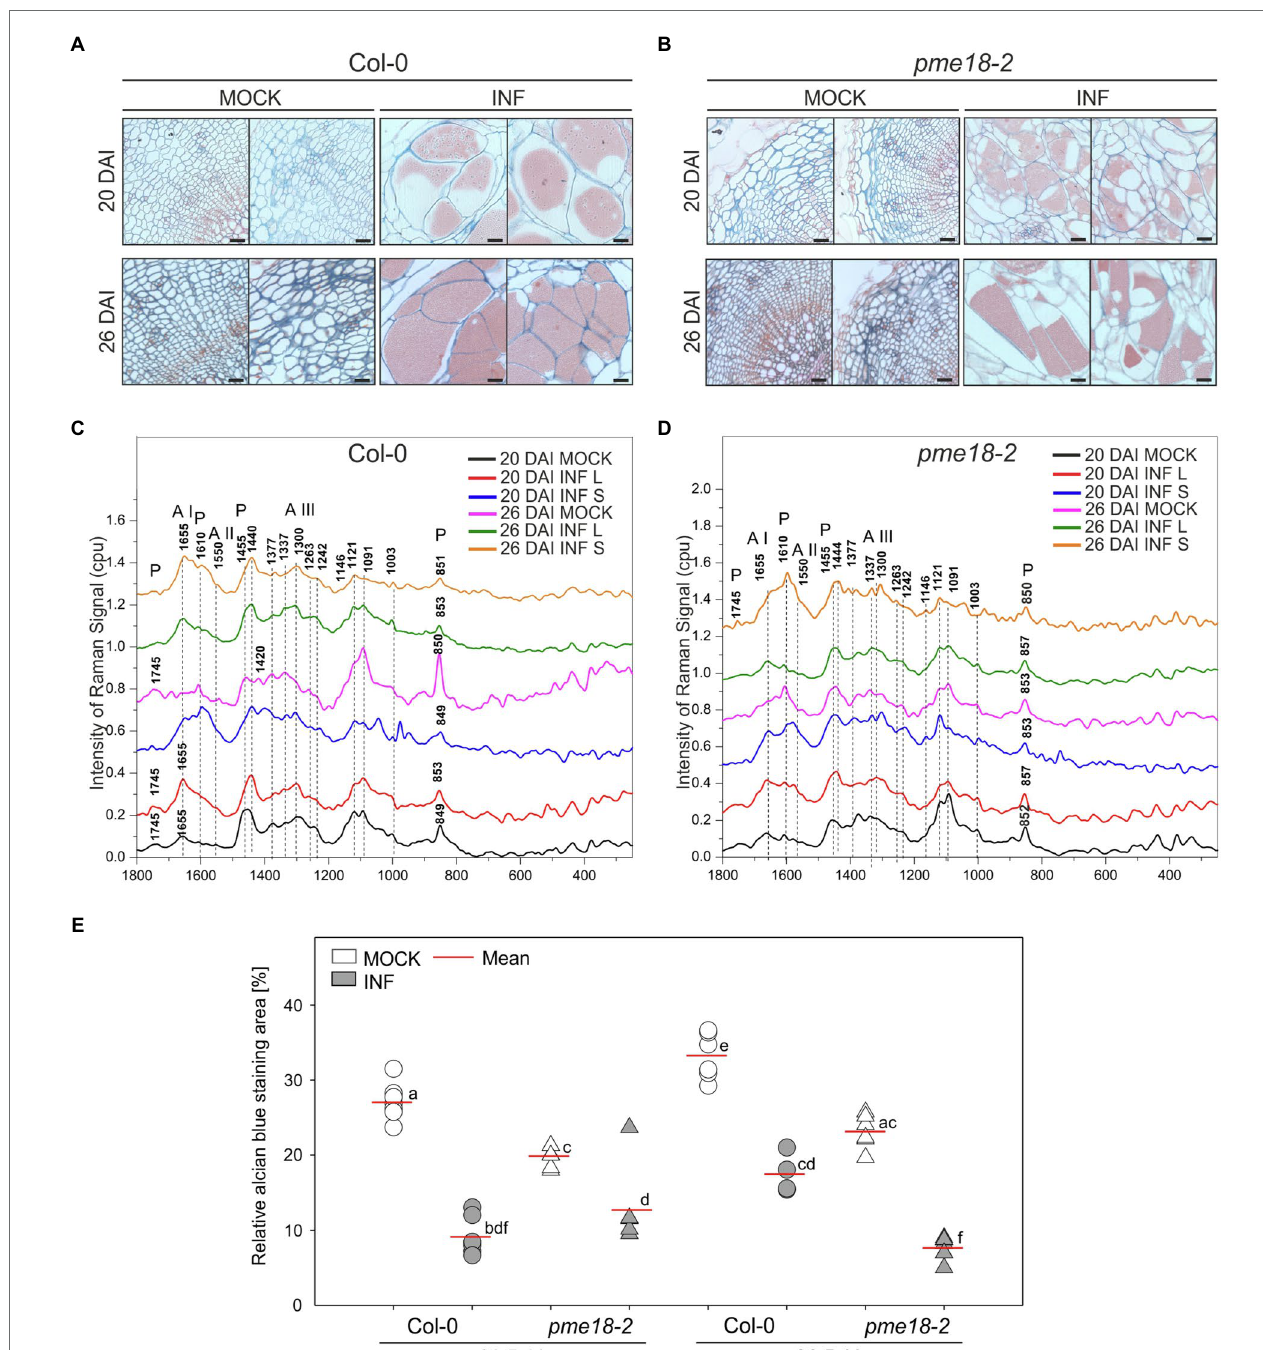
FIGURE 4 | Pectin distribution and pectin methylation status in the hypocotyl cell walls of P. brassicae- infected and mock-inoculated Col-0 and pme18-2 plants. (A,B) Fragments of the representative transverse 5 μ m sections across hypocotyls of Col-0 and pme18-2 plants 20 DAI and 26 DAI double-stained with alcian blue (for de-esterified pectin) and safranin O (used as a counterstain). Scale bars represent 100 μ m. (C,D) Raman spectroscopy results with spectral range of 1800 to 250 cm − 1 obtained for cell walls in mock-treated and infected hypocotyls of Col-0 and pme18-2 plants 20 DAI and 26 DAI. Separate measurements for enlarged cells (INF L) and those that did not undergo pathogen-driven expansion (INF S) within galls are presented. The Raman spectra intensities are presented as relative values. To avoid overlapping and facilitate observation of discrete differences spectra were separated. (E) Alcian blue staining area in mock- and P. brassicae - inoculated Col-0 and pme18-2 plants 20 DAI and 26 DAI. Scatter plots present individual measurements of alcian blue staining area relative (in %) to the total hypocotyl section area (between four to seven replicates for each combination) and calculated means. Different letters indicate significant differences between means (Tukey’s test, p <